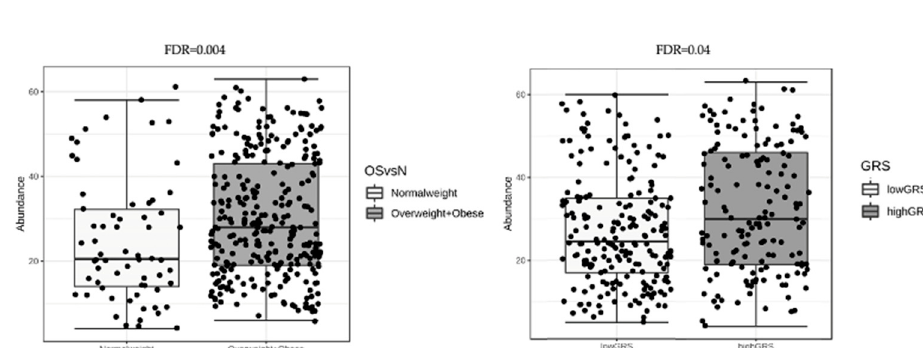
Figure 4. ( A ) Box plot of Prevotellaceae abundance in metagenomeSeq analysis between normal weight and overweight + obese subjects. ( B ) Box plot of Prevotellaceae abundance in metagenomeSeq analysis between low-GRS and high-GRS subjects. FDR: false discovery rate adjusted p value.